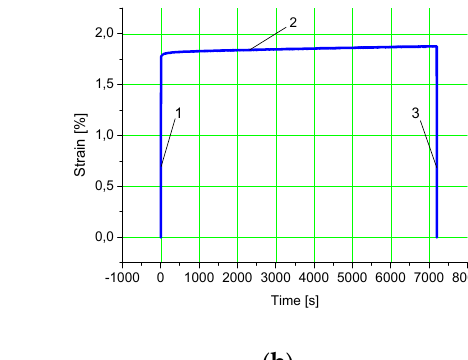
Figure 2. Experimental curves for the specimens SLS fabricated from polyamide-aluminum powder: ( a ) stress relaxation (1—loading represented by the quasi-step function, 2—relaxation, and 3— unloading), ( b ) creep (1—loading represented by the quasi-step function, 2—creep, and 3— unloading).